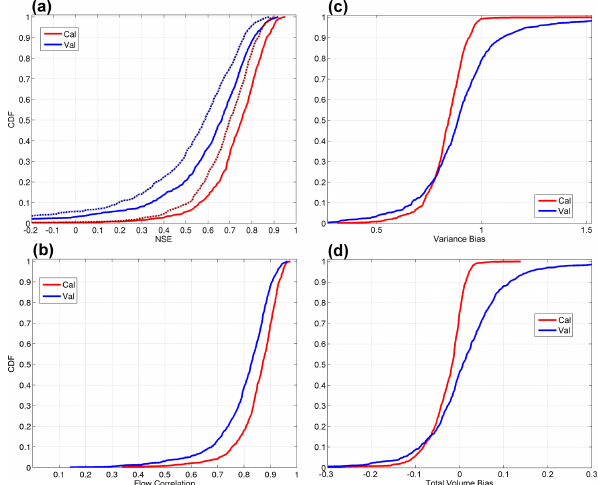
Figure 7. (a) CDFs of the model NSE (solid) for the calibration (red) and validation periods (blue) and NSE using the MNSEs (dark shaded and dashed). CDFs for (b) simulated–observed flow corre- lation in the decomposition of the NSE, (c) for the variance bias in the decomposition of the NSE, and (d) total volume bias in the decomposition of the